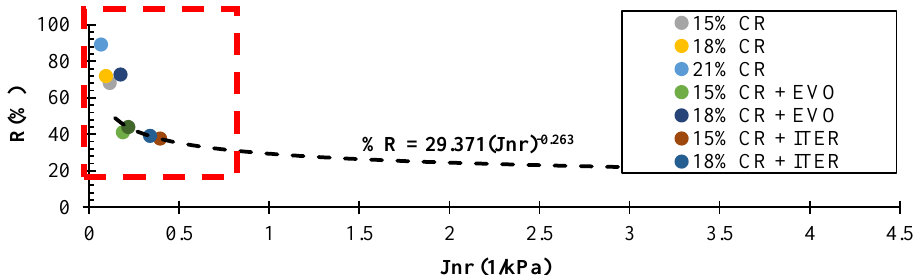
Figure 15. Plot of percentage recovery vs J nr for modified asphalt binders.